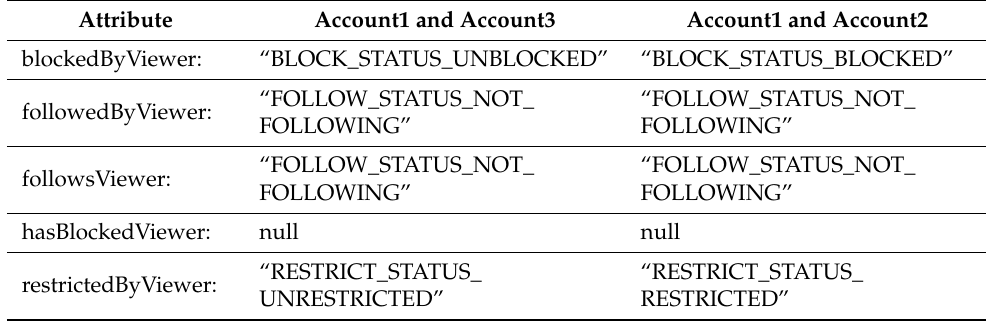
Table 6. Artifacts Found in relationships Record with User Profile Interactions.